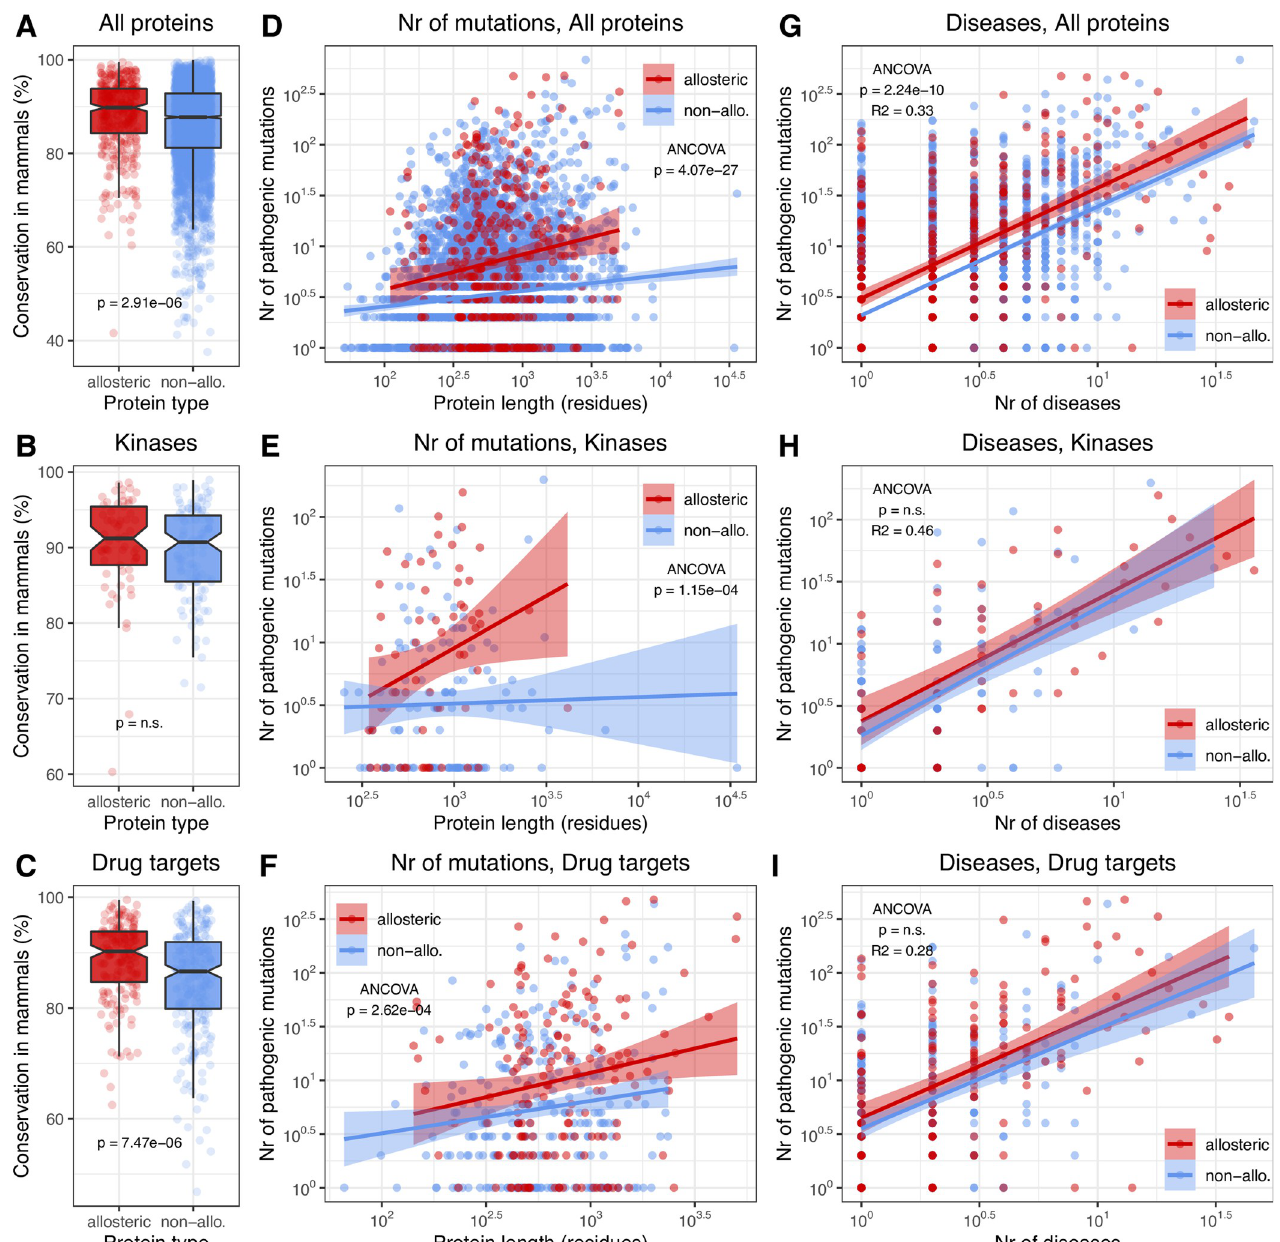
Fig 5. Conservation, mutation density, and disease associations of allosteric and non-allosteric proteins involved in disease. Kinases and drug targets are shown separately. A-C) Allosteric proteins are characterised by a somewhat higher conservation than non-allosteric proteins. D-F) Allosteric proteins are characterised by significantly higher numbers of pathogenic mutations than non-allosteric ones. G-I) Despite having more pathogenic mutations, the relationship between the number of diseases, and the number of pathogenic mutations is qualitatively similar for allosteric and non-allosteric